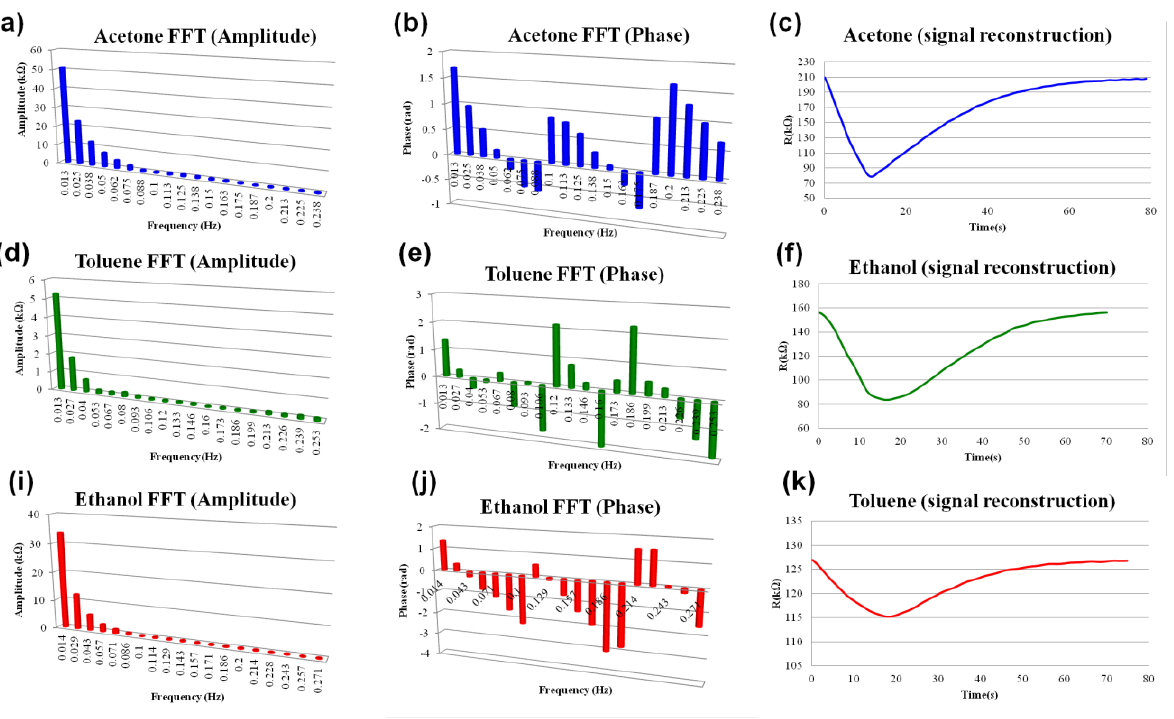
Figure 5. Spectral structure of the first twenty harmonics and the signal reconstruction